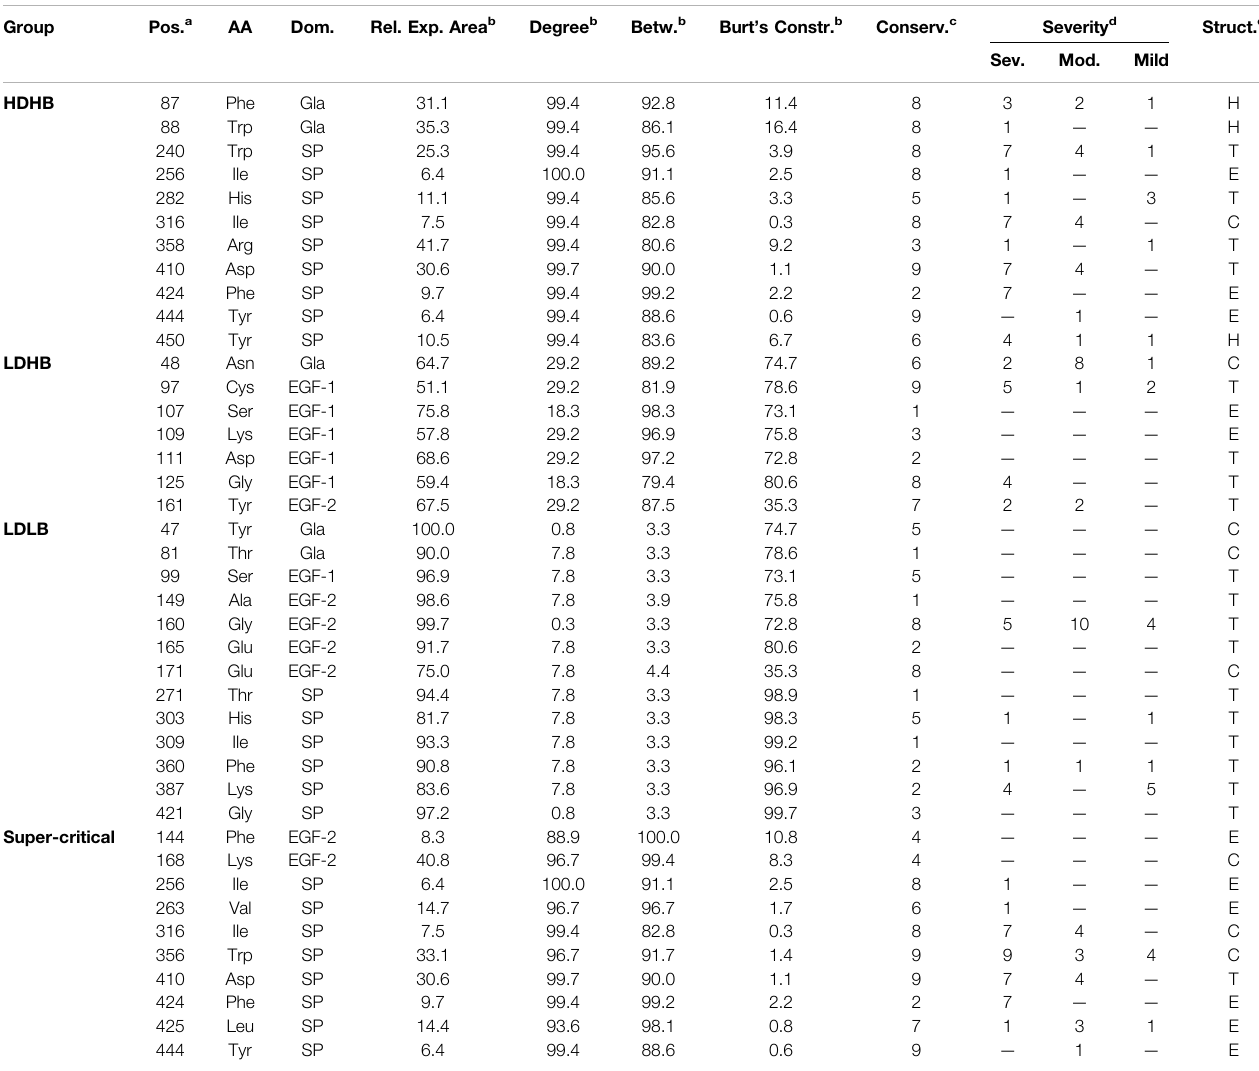
TABLE 1 | Key-residues identi fi ed using the centralities of the FIX RIN. Group Pos. a AA Dom.